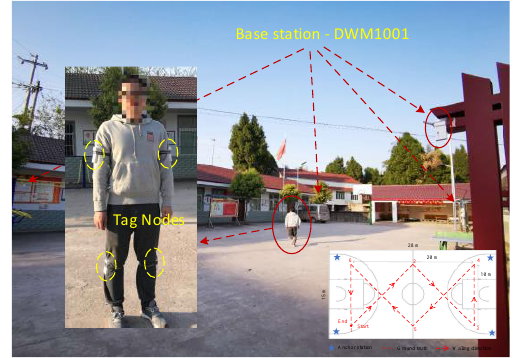
Figure 6. A panoramic view of the base station placement, experimental arena, and the route.